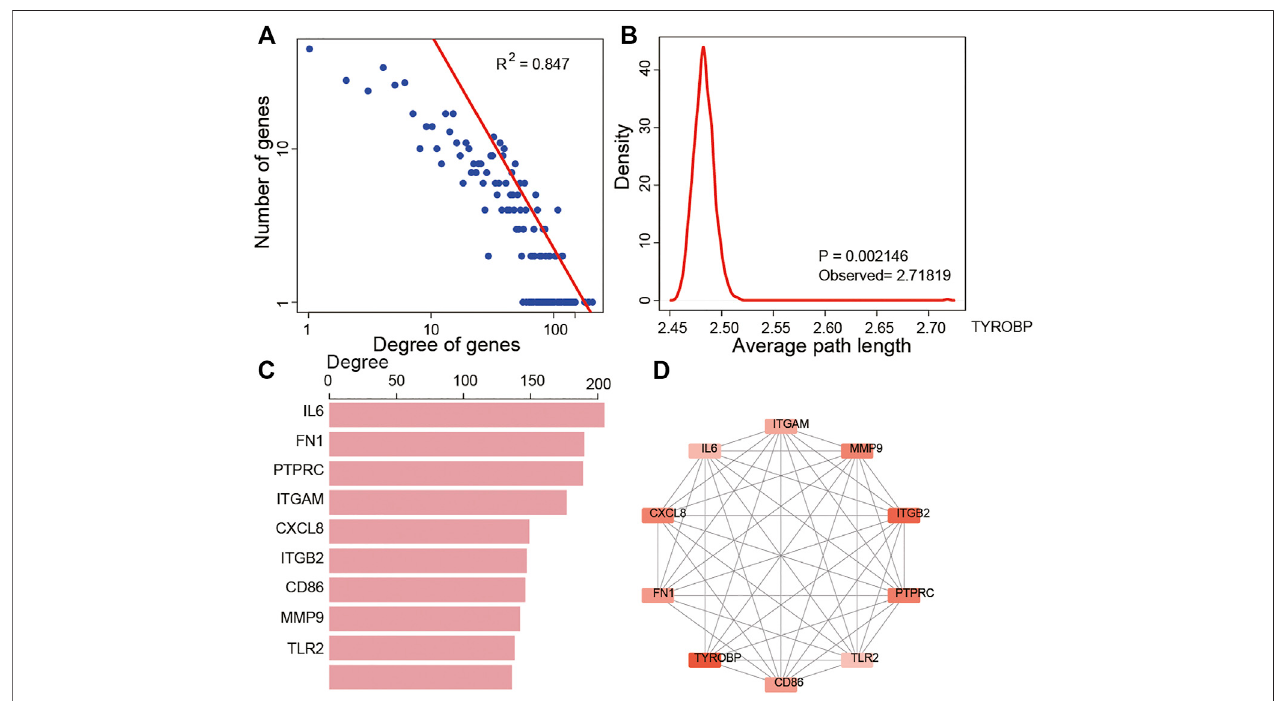
FIGURE 5 | Topological features of DEGs in the PPI network. (A) View of the PPI network. (A) Degree distributions of the PPI network. (B) All degrees followed a power-lawdistribution andaveragepath lengthdistributionsoftherealnetworkand1,000times randomnetworks. (C) KeyDEGsinthePPInetworkwithtop10degree distributions. (D) Subnetwork of the top 10